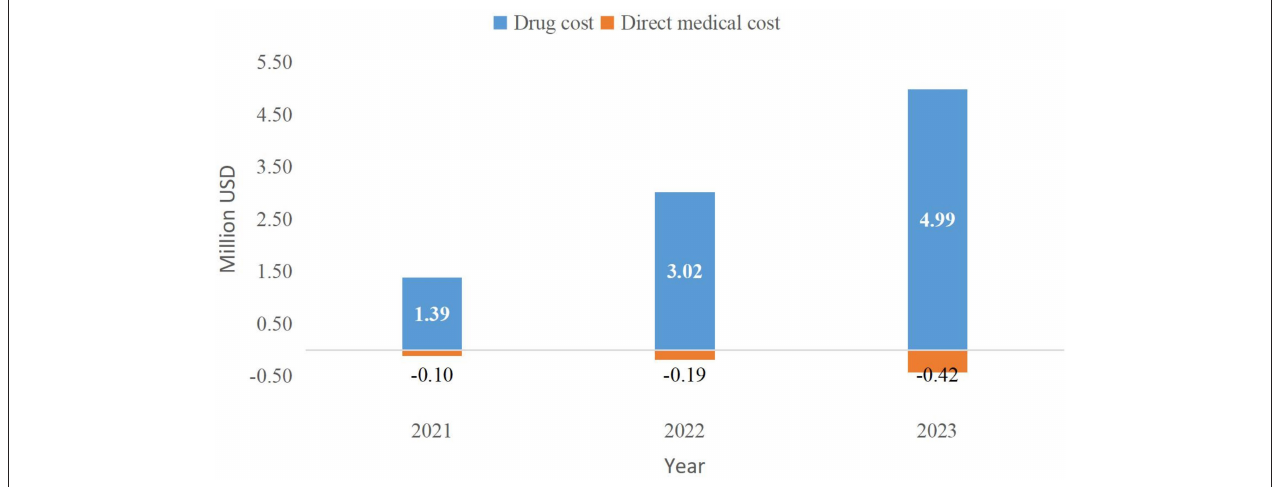
FIGURE 5 | Incremental budget impact of the inclusion of PER in the NRDL (2021–2023). NRDL, National Reimburesement Drug